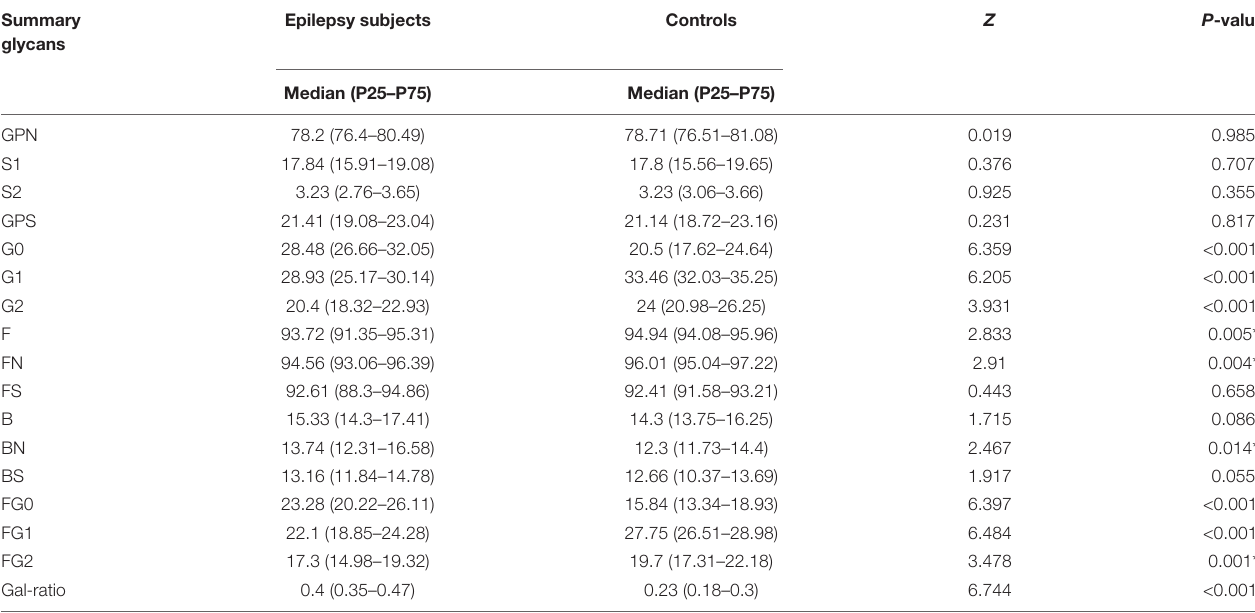
TABLE 3 | Relative abundance (%) of main IgG glycome features in epilepsy patients and the healthy